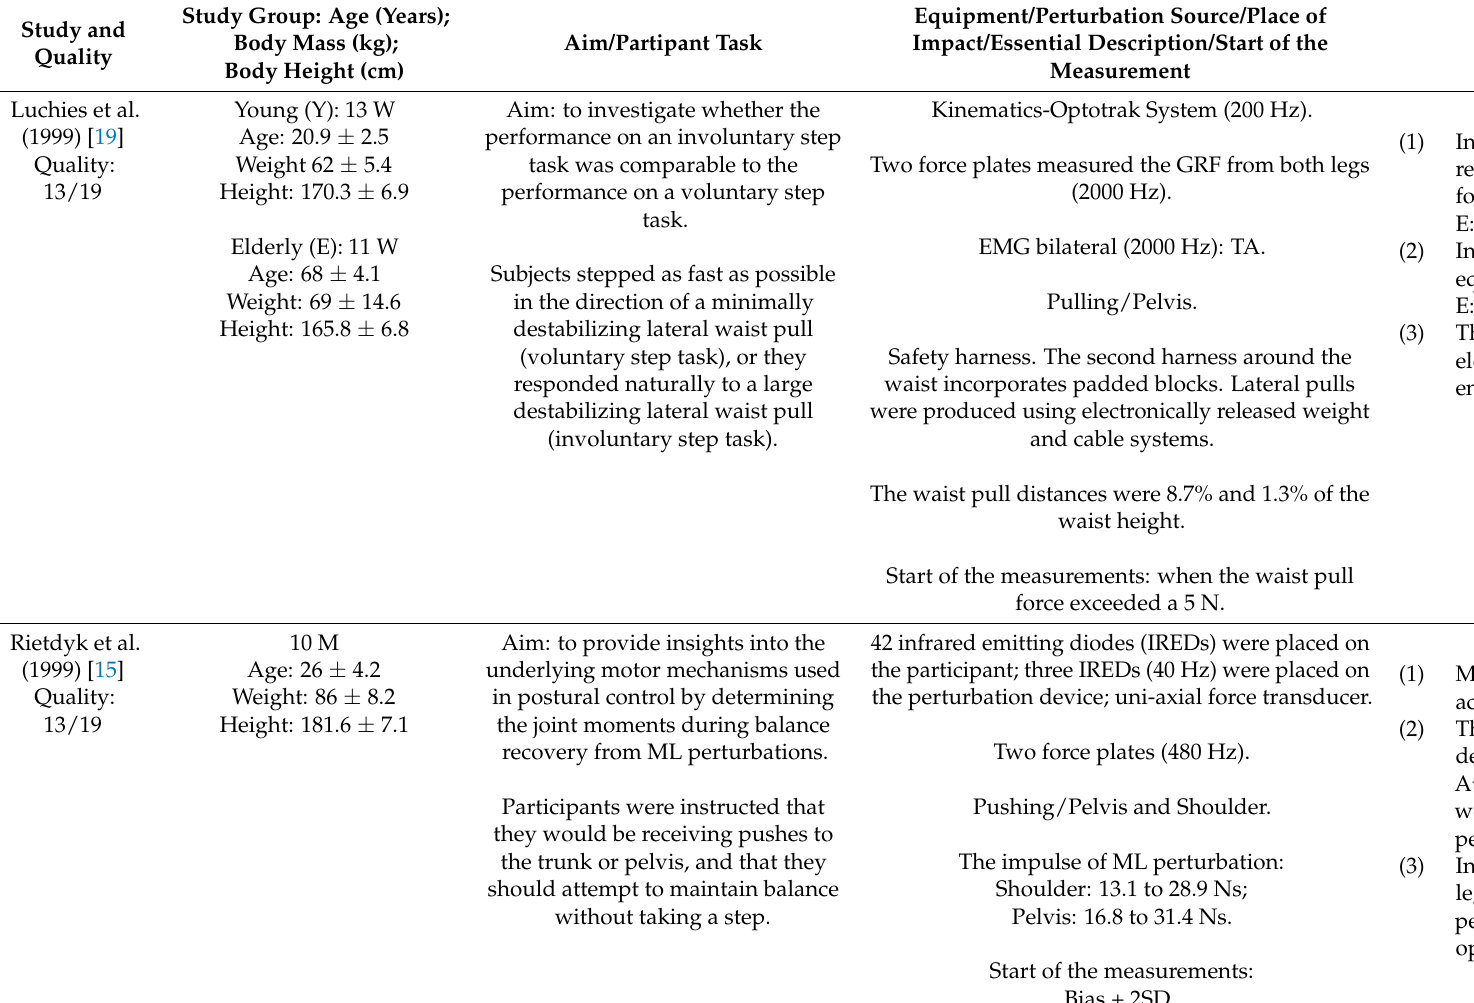
Table 2. Data extracted from reviewed